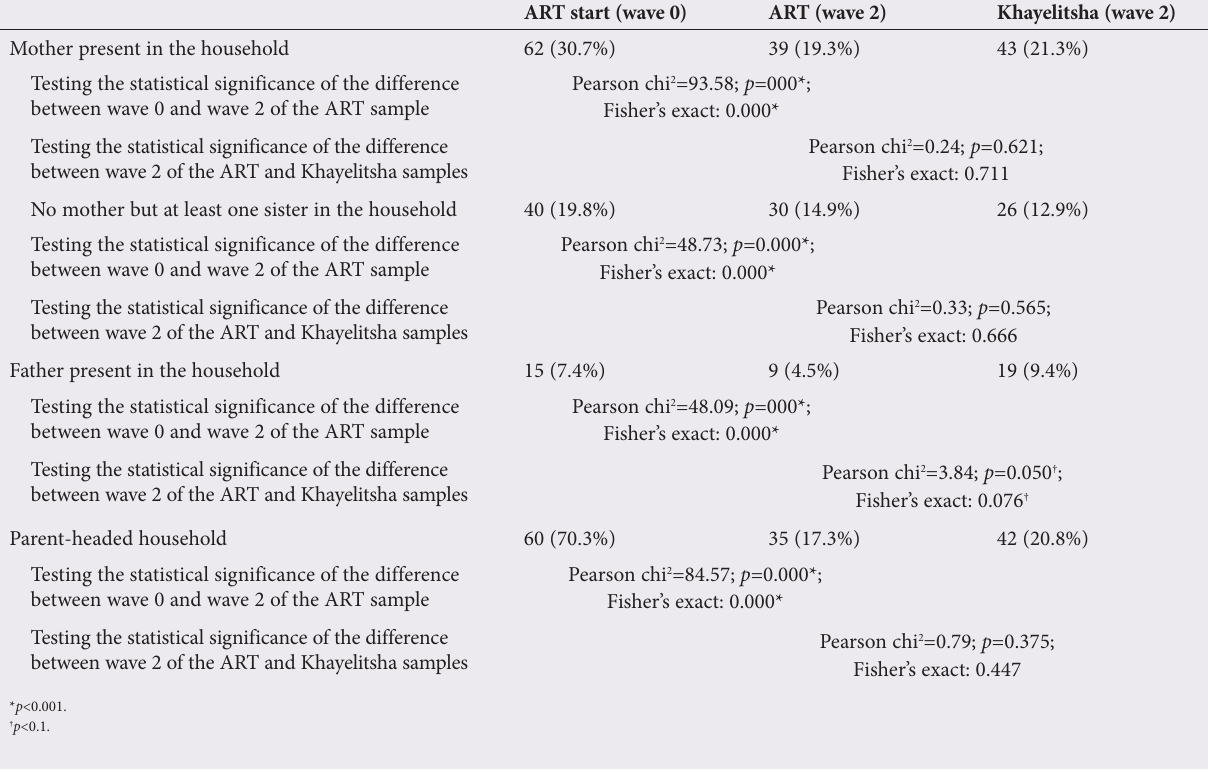
Table 3. The presence of mothers, sisters, fathers and parent-headed